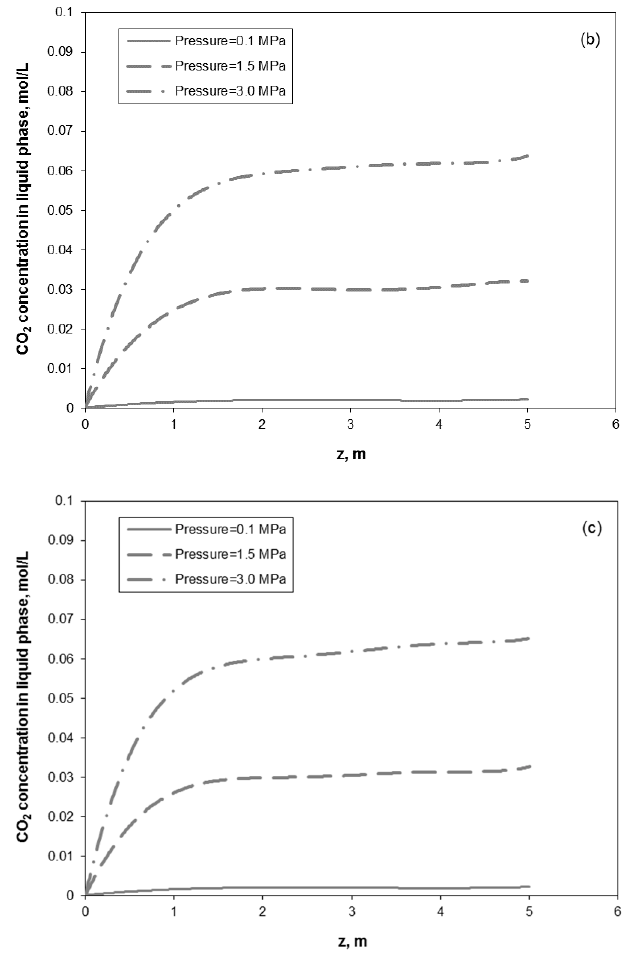
Figure 6. Steady-state axial profiles of liquid phase CO 2 concentration at different values of scrubber pressure (H = 5 m): ( a ) Packed-bed column with Raschig super-Rings; ( b ) Packed-bed column with I-Rings; ( c ) Packed-bed column with Pall-Rings.